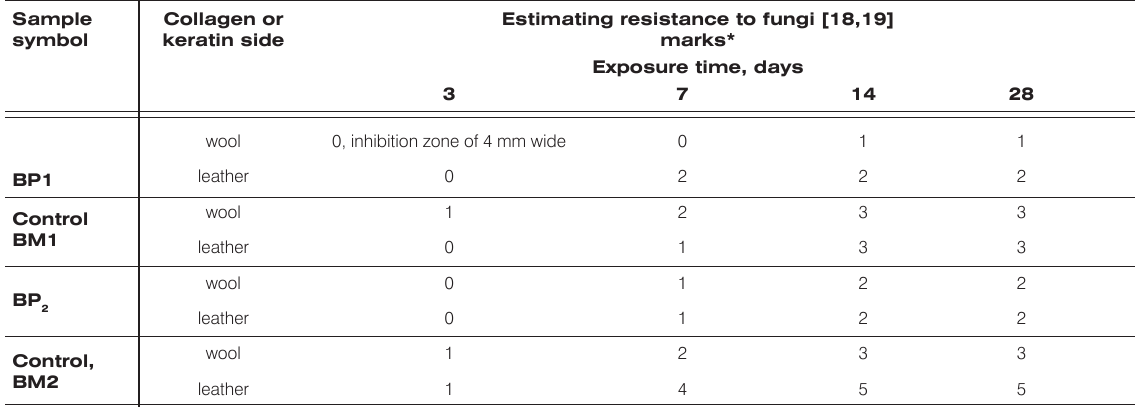
Table 4. The resistance of sheepskins treated with AgNPs to a mix of fungi. Sample symbol